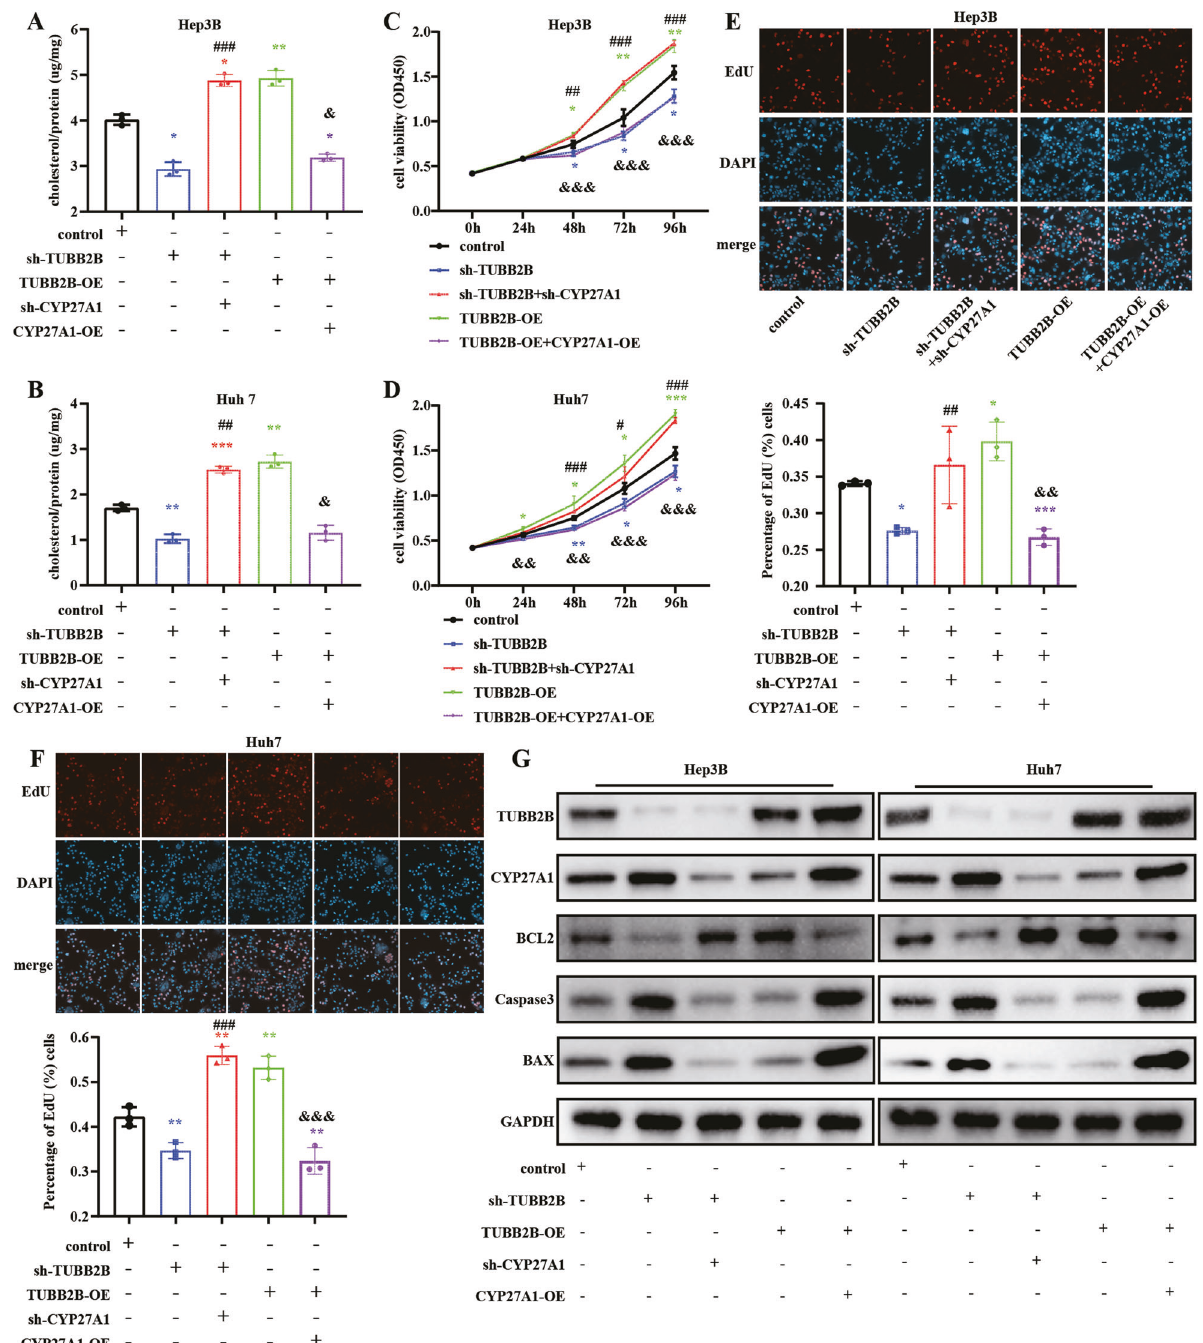
Fig. 5 TUBB2B regulates CYP27A1 to affect cholesterol degradation and cell proliferation and apoptosis. A , B Cholesterol level in Hep3B and Huh7 cells treated as shown. C – F Cell proliferation of Hep3B and Huh7 cells measured by CCK8 and EdU assays. Quanti fi cation of EdU results after indicated treatment. G Western blot analysis of apoptotic markers in Hep3B and Huh7 cells after different treatment ( n = 3/per group). Experimental group compared to control group: * p < 0.05, ** p < 0.01, *** p < 0.001. sh-TUBB2B group compared to sh-TUBB2B + sh- CYP27A1 group: # p < 0.05, ## p < 0.01, ### p < 0.001. TUBB2B-OE group compared to TUBB2B-OE + CYP27A1-OE: & p < 0.05, && p < 0.01, &&& p <